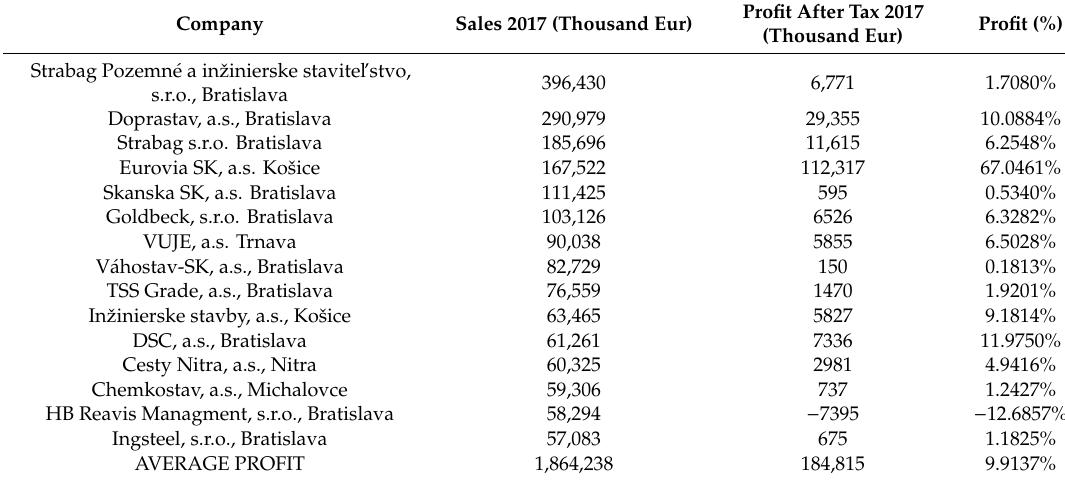
Table 1. Sales and profits after construction companies in 2017